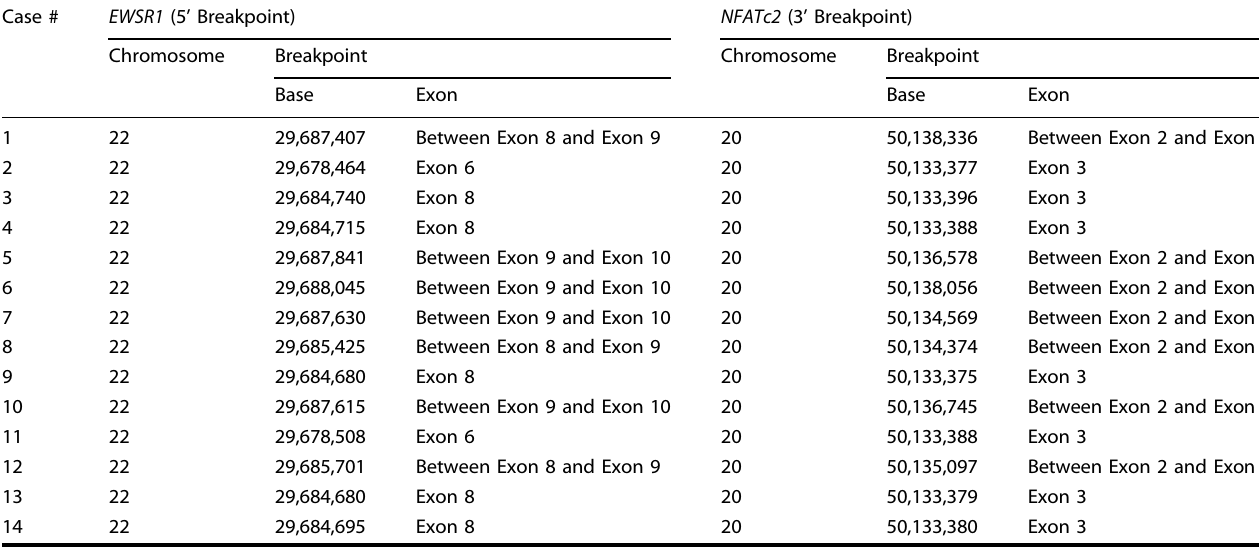
Table 2. Detected breakpoints in EWSR1-NFATc2